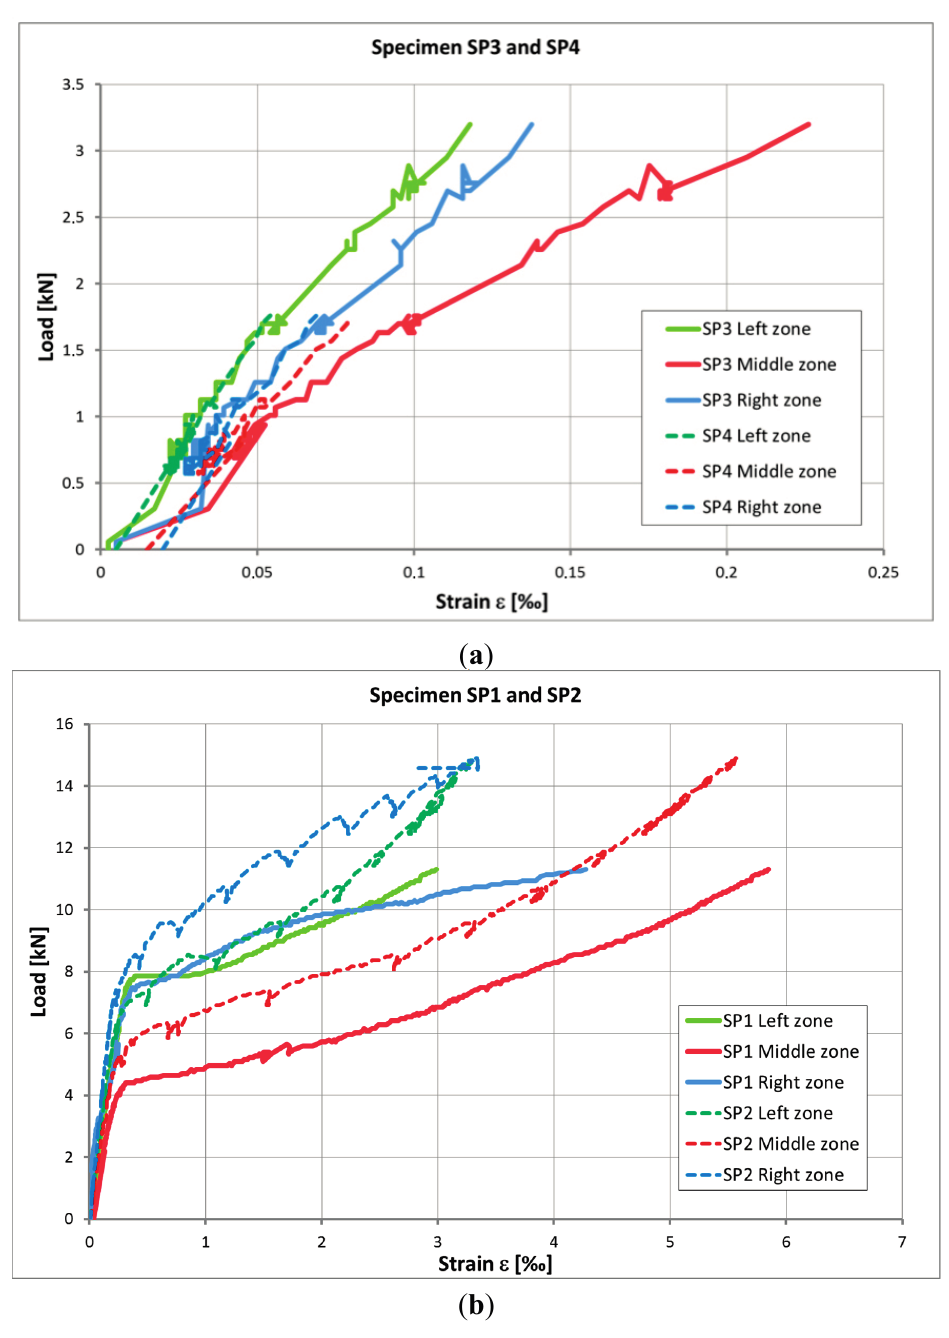
Figure 8. Strain-Load relationship for: ( a ) specimens SP3 and SP4 (without reinforcement) and ( b ) specimens SP1 and SP2 (with